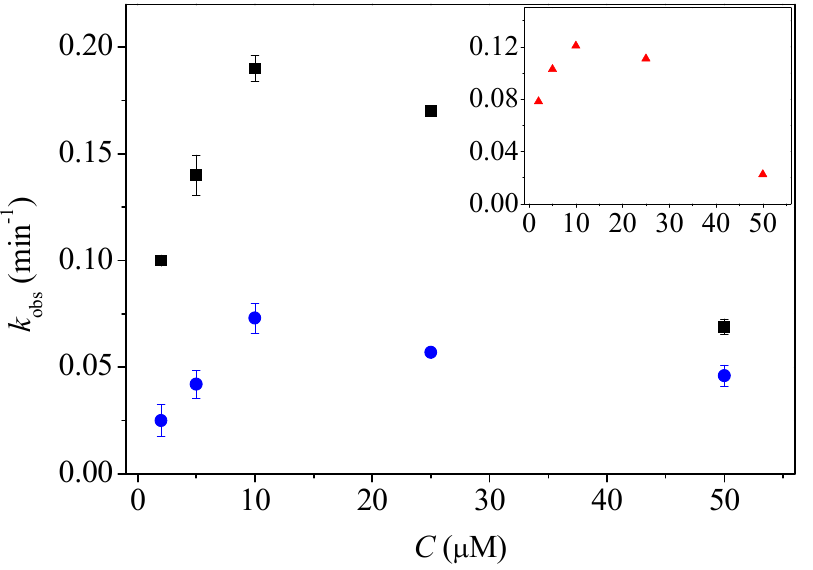
Figure 2. Observed degradation rate constant ( k obs ) of CTZ with different initial concentration in UV (circle) and UV/chlorine (square) system (pH = 7.0, (Free chlorine) 0 = 100 µM. The insert figure represents the differences in k obs values in UV/chlorine system compared with those under UV treatment alone. The error bars represent the 95% confidence interval ( n = 3)).